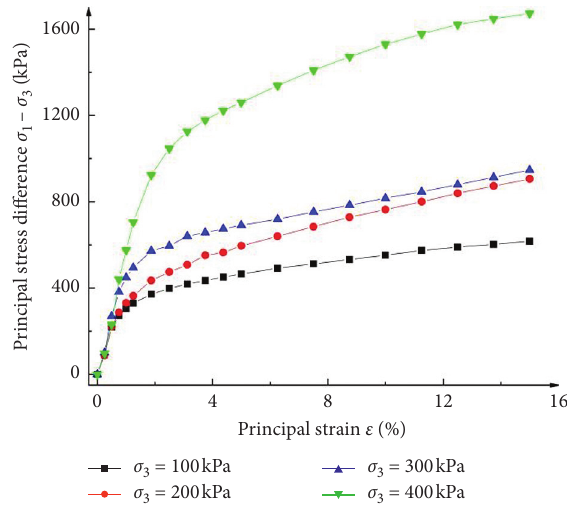
Figure 5: Stress-strain relationship obtained from the consolidated undrained triaxial test of the soil samples.